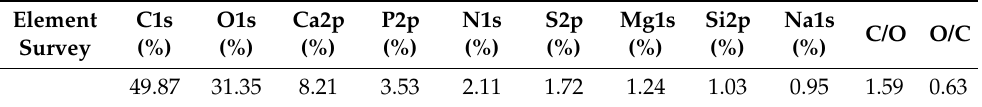
Figure 5. High-resolution XPS spectra of ( a ) C1s and ( b ) O1s peaks. Table 1. The weight percentages and ratios of the surface element compositions of the Catalpa bignonioides